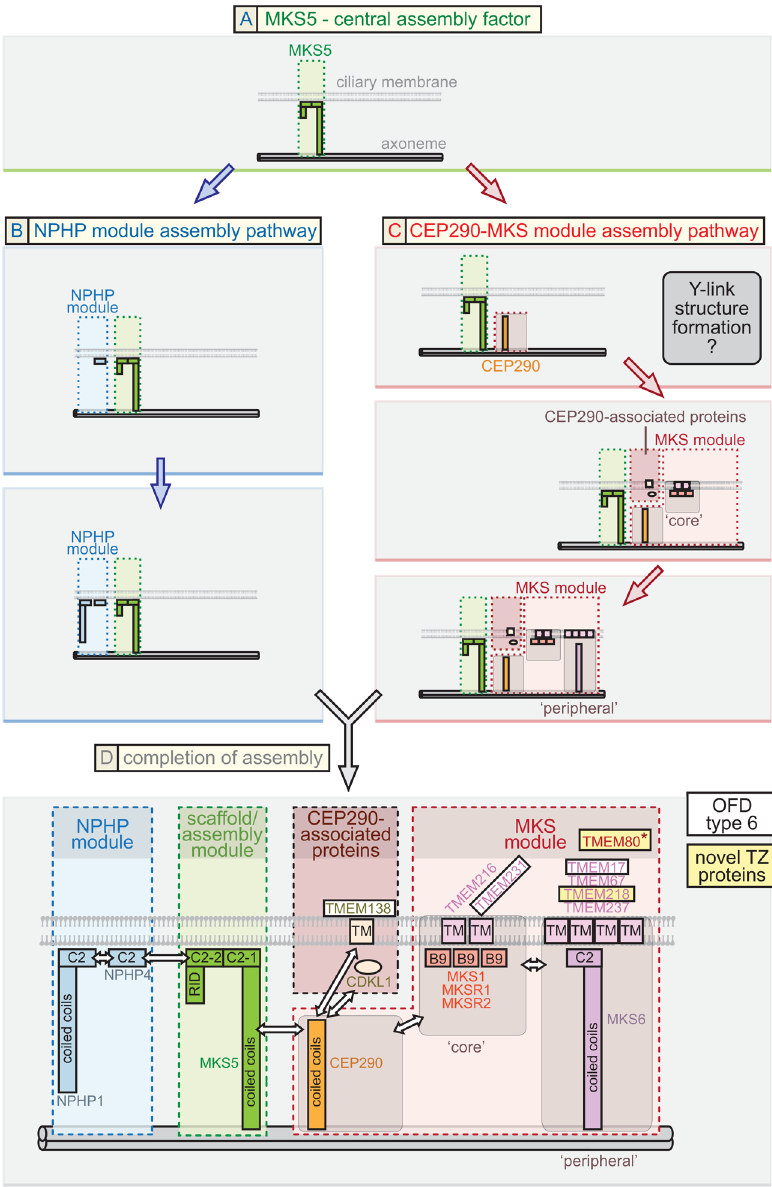
Fig 7. Proposed model for ciliary transition zone assembly. This model for the assembly of proteins at the TZ is based mostly on C . elegans data but is largely consistent with findings from other organisms, including mammals, Chlamydomonas , and Drosophila . ( A ) MKS5: central assembly factor . C . elegans MKS-5 (mammalian Rprgrip1L/Rpgrip1 orthologue) is essential for the assembly of all known TZ proteins (including CEP-290) and, therefore, may be the first component to establish the TZ. MKS-5 directs two genetically separable (distinct) assembly pathways, involving NPHP module proteins (blue arrows) as well as CEP-290, CEP-290-associated proteins, and MKS module proteins (red arrows). ( B ) NPHP module assembly pathway . Results from this study, other C . elegans findings, and mammalian work suggest that NPHP module proteins function together with MKS-5. We propose that the NPHP module, which can assemble at the TZ in the absence of CEP-290 (red pathway), assembles either before or in conjunction with the CEP-290-dependent pathway. NPHP-1 requires NPHP-4 for assembly at the TZ and is, therefore, positioned “ downstream ” in the pathway. ( C ) CEP290-MKS module assembly pathway . CEP-290 depends on MKS-5 for its TZ localisation and is, therefore, shown to assemble “ downstream ” in the pathway. Established MKS module proteins, including “ core ” components, require CEP-290 for TZ localization and are shown to assemble “ downstream. ” Another subset of TZ proteins (CDKL-1, TMEM-138) depends on